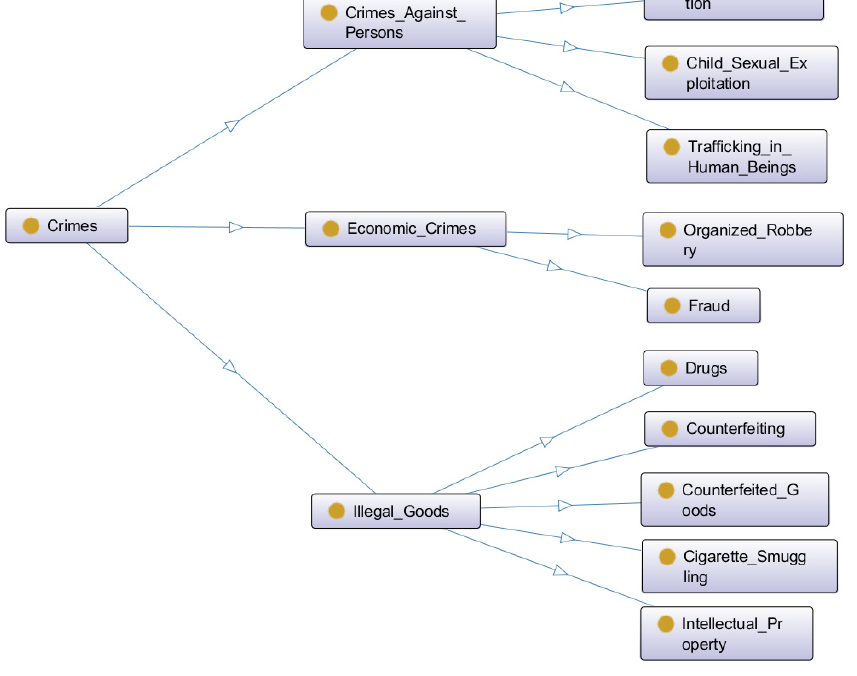
Fig. 3. Europol OCS (created from Ref.